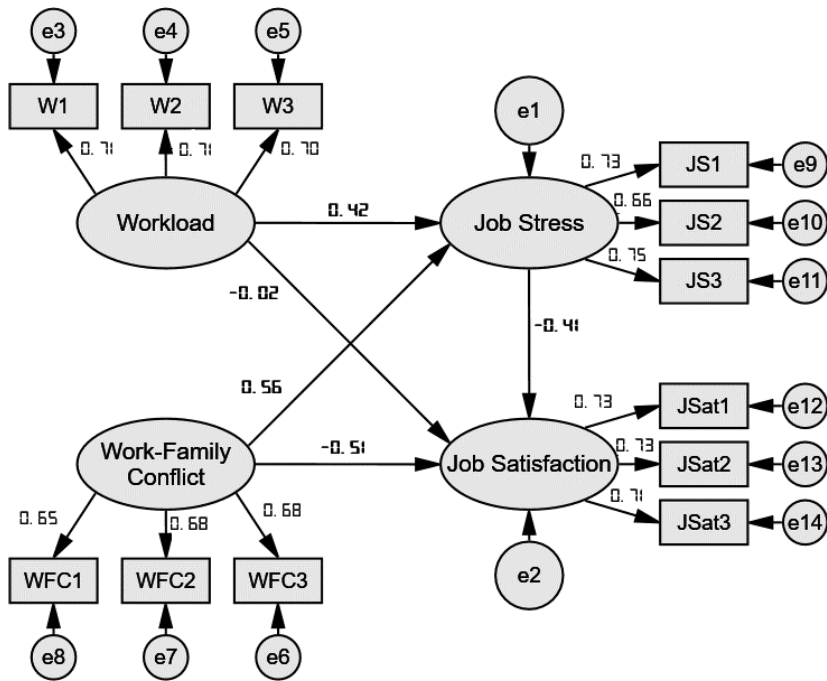
Figure 2. Results of